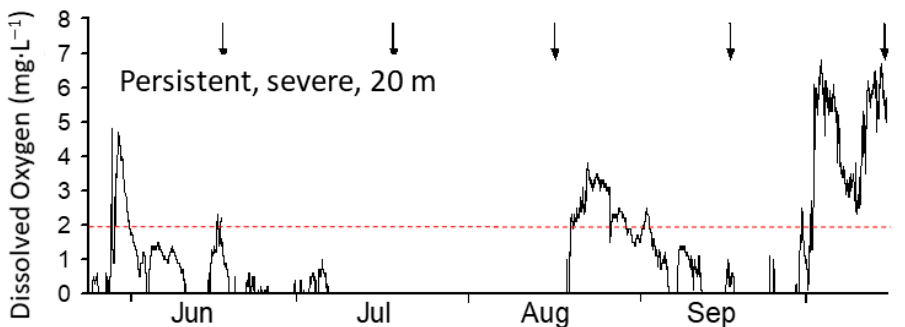
Figure 6. Time series plot of near-bottom dissolved oxygen concentration at a 21-m station (C6) that is 100 km west of the Mississippi River delta in 1990 [15,45]. The horizontal dashed line defines hypoxia. Zero values indicate anoxia or close to anoxia 0.0 ± 0.2 mg·L − 1 . Arrows indicate sampling periods from June 1990 through October 1990 that correspond with benthic communities in Figure 7. Benthic samples were taken from a 0.1-m 2 GOMEX box corer into which a small, hand-operated Ekman grab (0.023-m 2 surface area) was inserted for a series of five replicate samples. Organisms captured on a ≥ 0.5-mm sieve were analyzed.